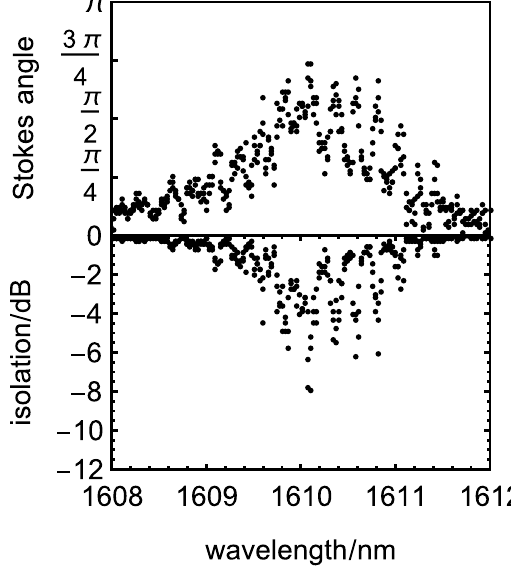
Figure 5. Performance of 500 nm SOI FR isolator with Ce:YIG/YIG claddings. (top) The Stokes vector angles of opposite magnetic saturation, where a peak relative angle of ~3/4 π was observed with this 4.1 mm long